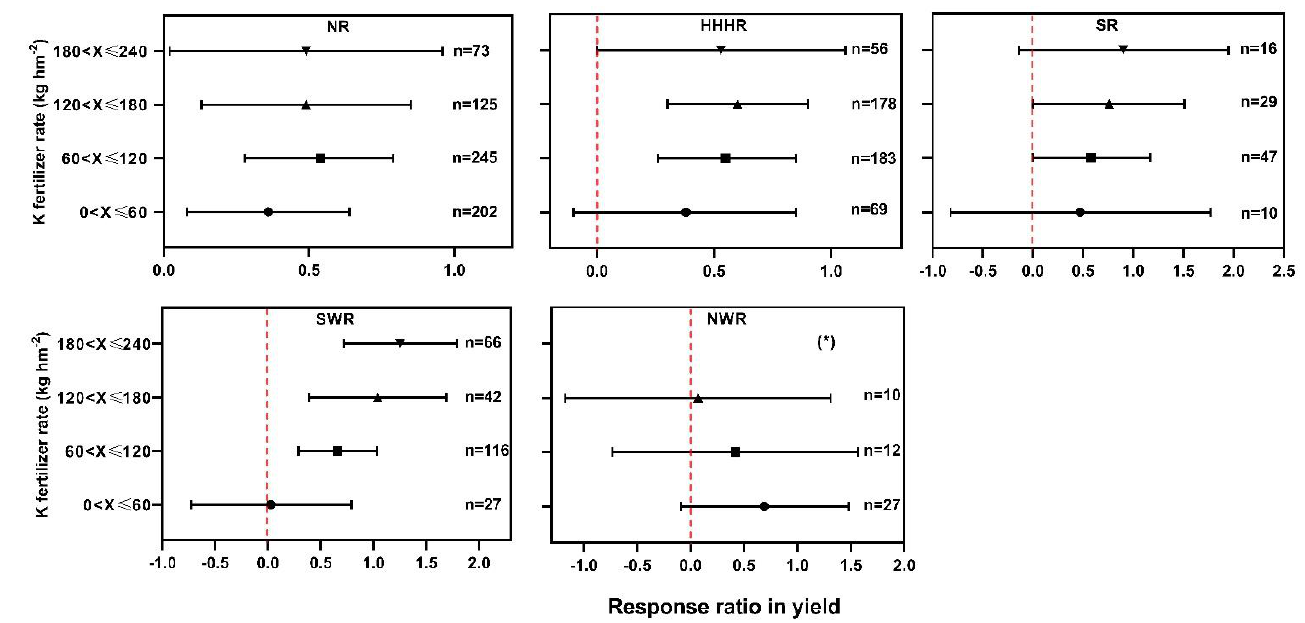
Figure 11. The effects of K fertilization levels on maize yield in each geographic region. NR: Northern region; HHHR: Huang − Huai − Hai region; SR: Southern region; SWR: Southwestern region; NWR: Northwestern region. The error lines indicate the 95th percentile bootstrap confidence intervals. n values indicate the corresponding number of observations (total number of control and treatment values). (*) indicates that a subgroup has an n value lower than nine. Yield with K fertilization is a treatment value, whereas yield without K fertilization is a control value.